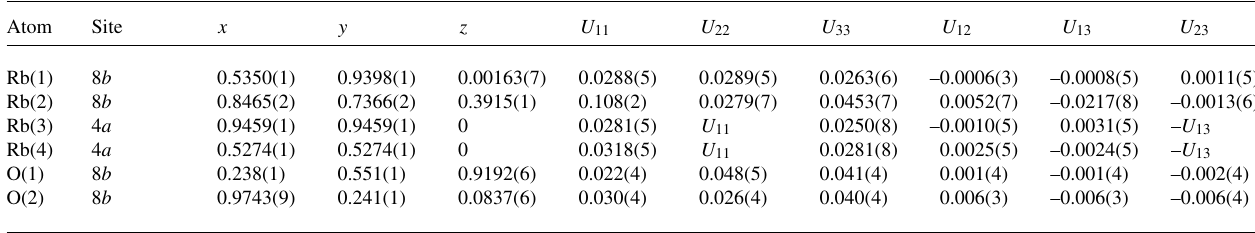
Table 3. Atomic coordinates and displacement parameters (in Å 2 )